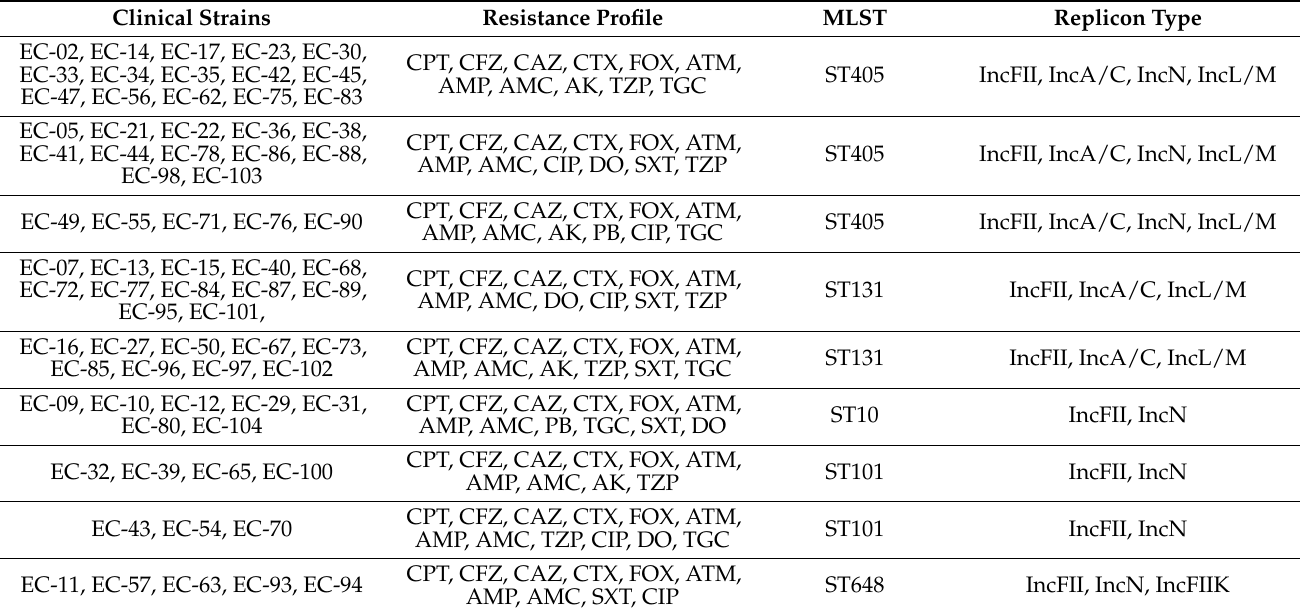
Table 2. Antimicrobial resistance and genetic profile of NDM-positive E. coli isolates.